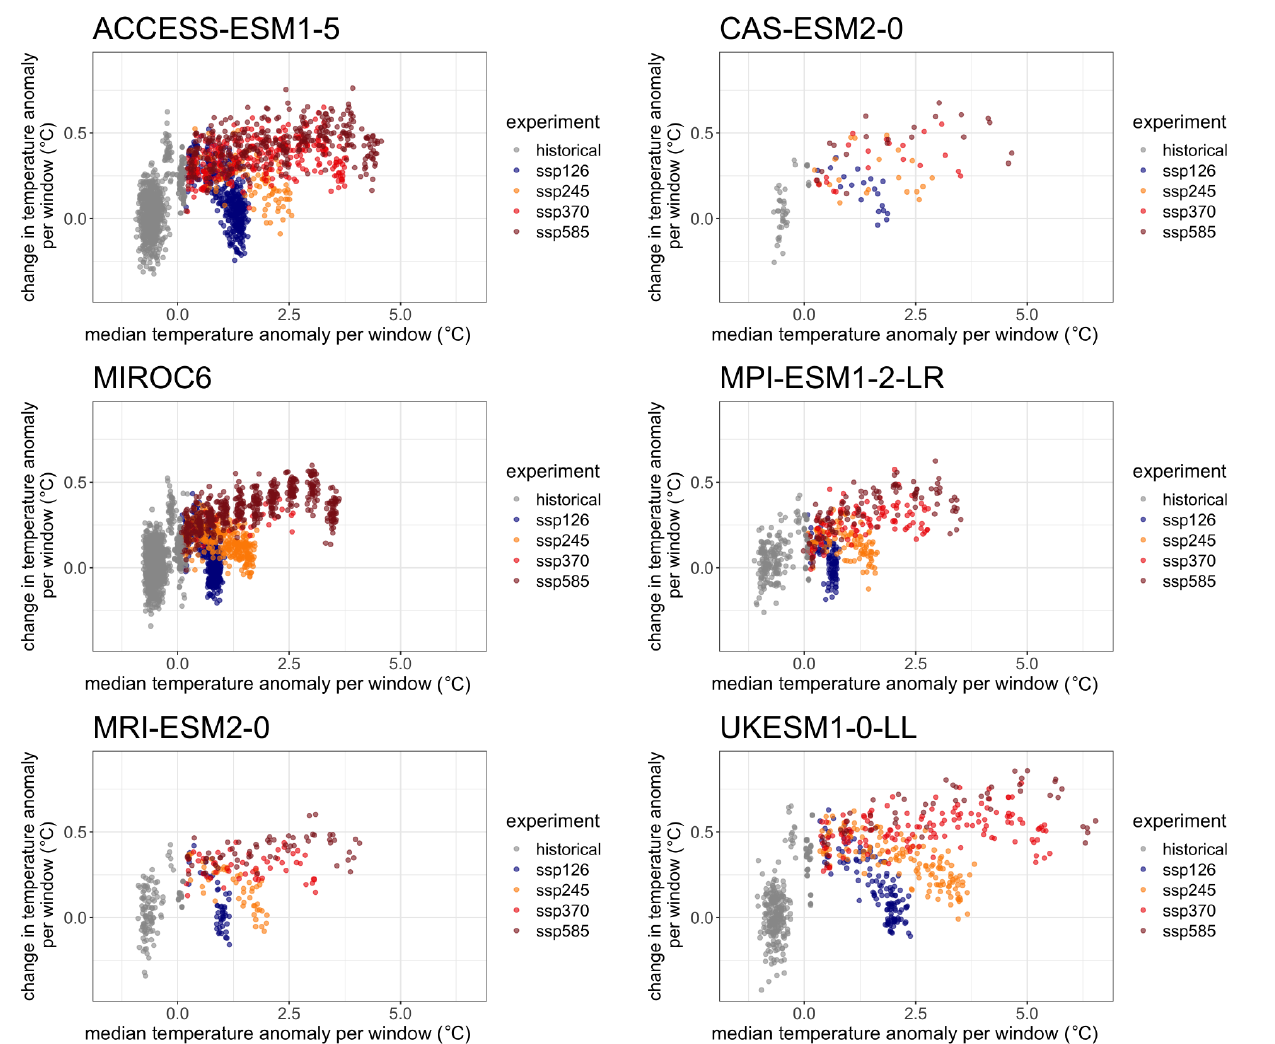
Figure 1. GSAT archive content, plotted in the space of ( T,X · d T ), i.e., the warming level with respect to the period 1995–2014 (as represented by the median value of the X annual values in the window) and the within-window rate of warming (as represented by a linear trend fitted to the X values) for six of the ESMs used in our emulation exercises. Each point corresponds to a X = 9-year-long window in the GSAT time series from an existing scenario simulation, indicated by the color